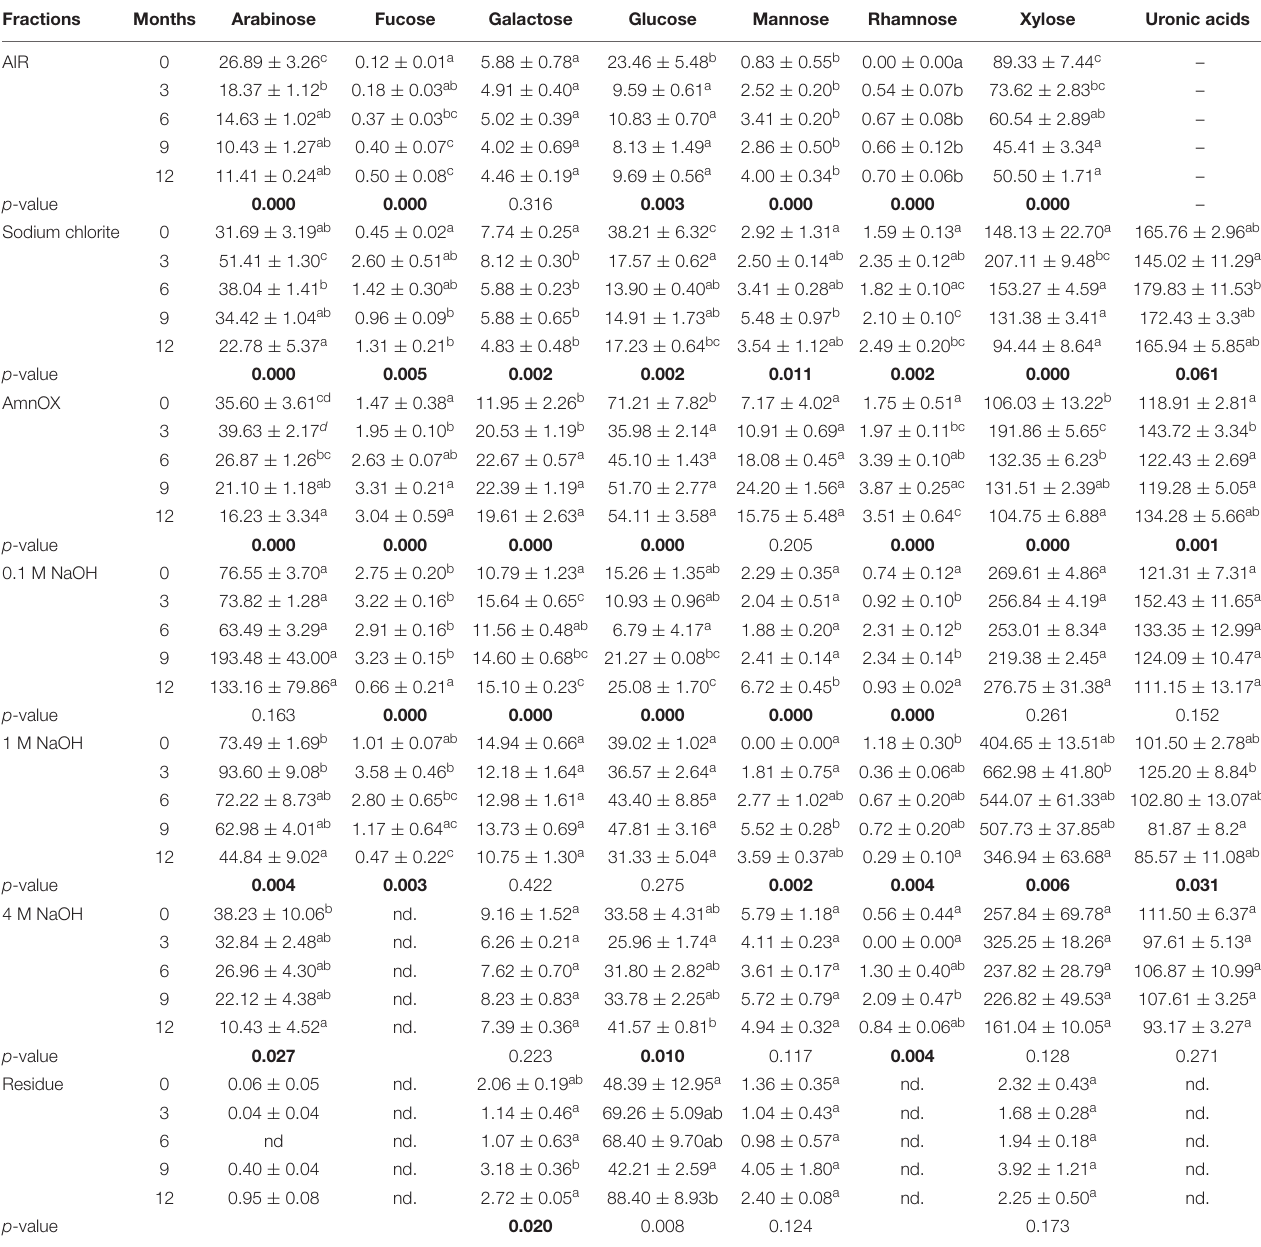
Values are represented by mean ± standard error expressed in µ g · mg − 1 dry weight. Different letters are significant differences by Tukey’s test (P < 0.05; n = 5). AIR (alcohol insoluble residue) represents the integrate cell wall and AmnOX represents ammonium oxalate fraction. nd. stands for not detected. Statistically significant p-values are shown in bold according to ANOVA one-way